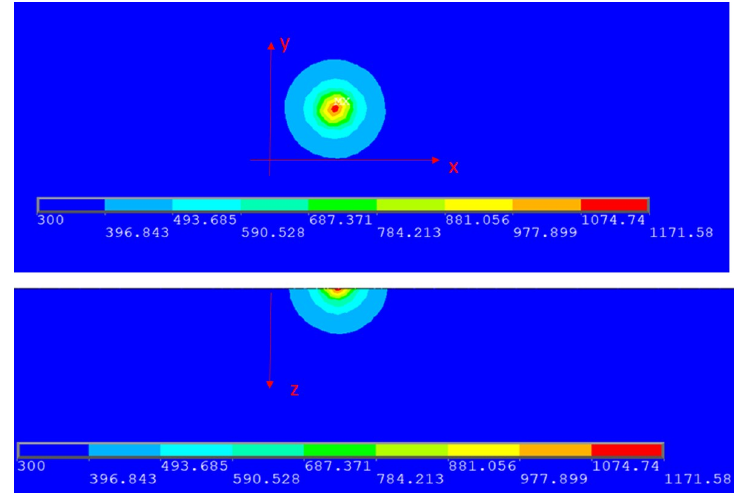
Figure 3. A temperature distribution of powder bed.